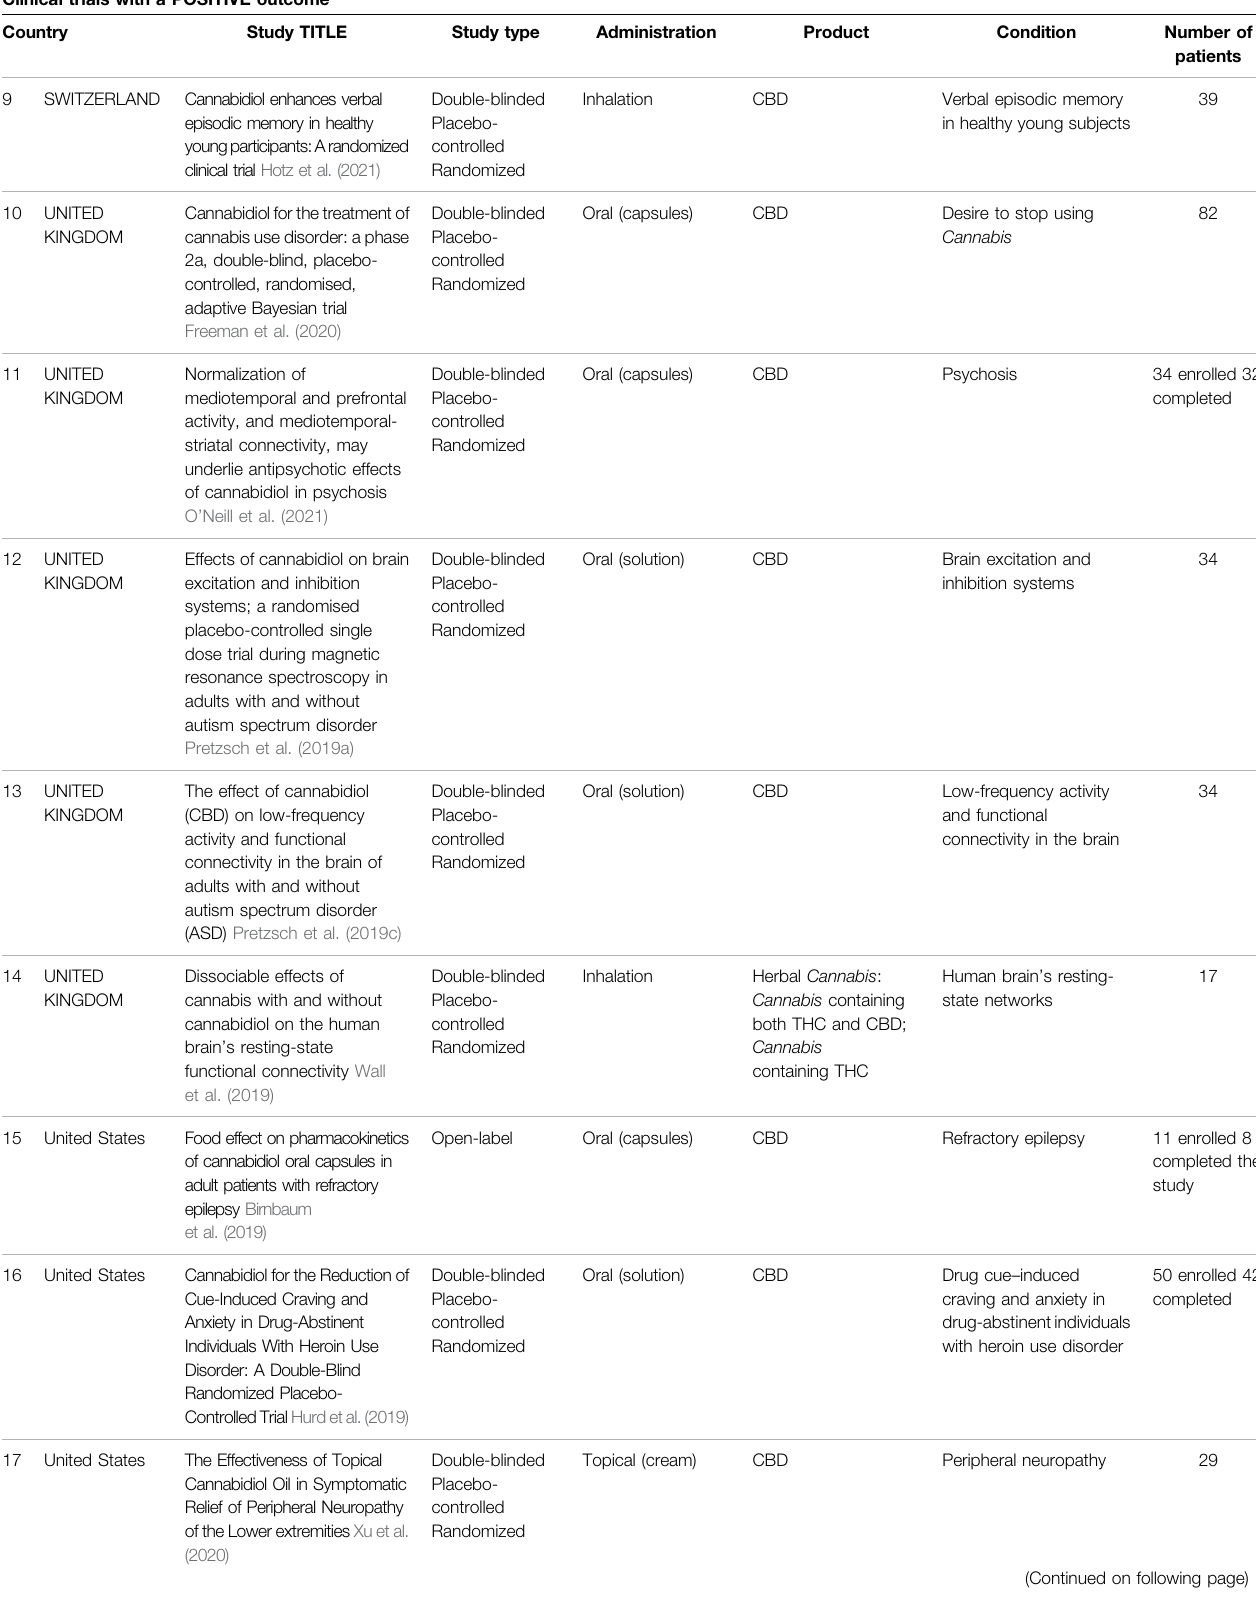
TABLE 1 | ( Continued ) Characteristics of the selected clinical